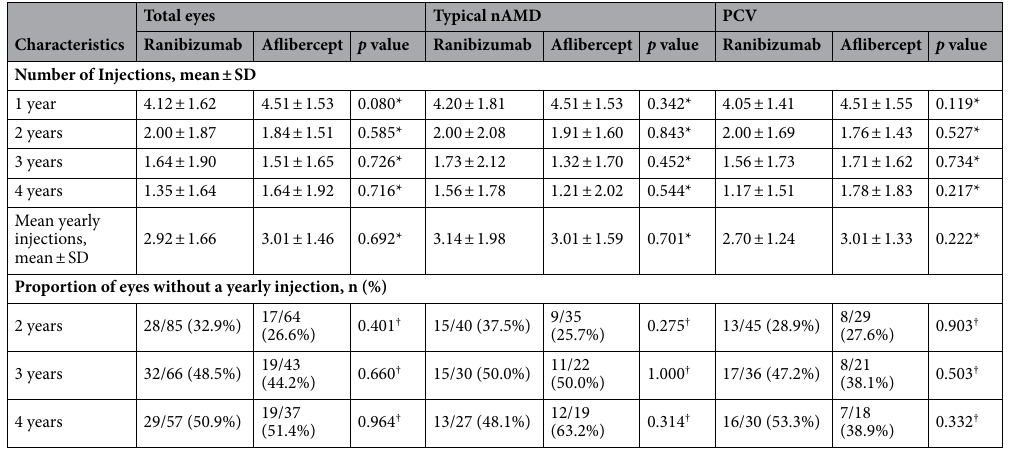
Table 3. Mean number of injections and proportion of eyes without a yearly injection. nAMD neovascular age-related macular degeneration, PCV polypoidal choroidal vasculopathy. *Independent t-test. † Pearson chi- square test.